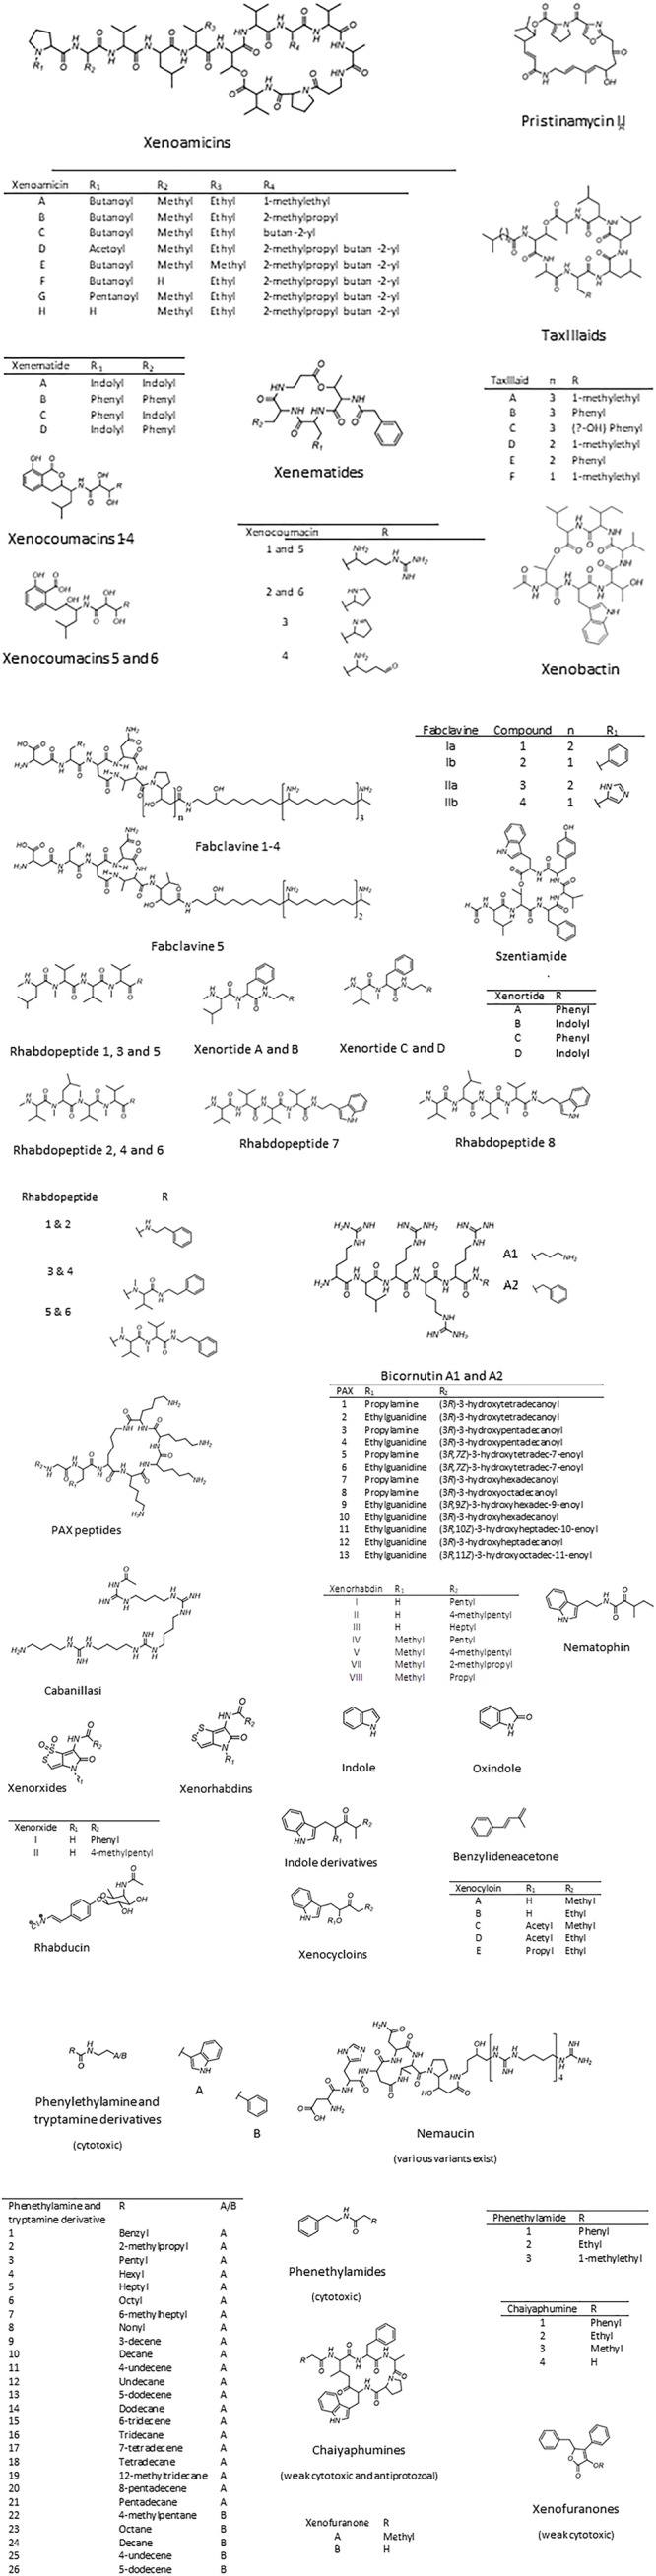
Xenorhabdus bioactive compounds. Bioactive compounds with unknown structures include the antibacterial xenoprotec, bicornituns C and D, and the two bacteriocins, xenorhabdicin, and xenocin. Compiled from Boemare et al. (1992), Paik et al. (2001), Hwang et al. (2003), El-Hag and El-Sadawy (2008), Gaultieri et al. (2012).